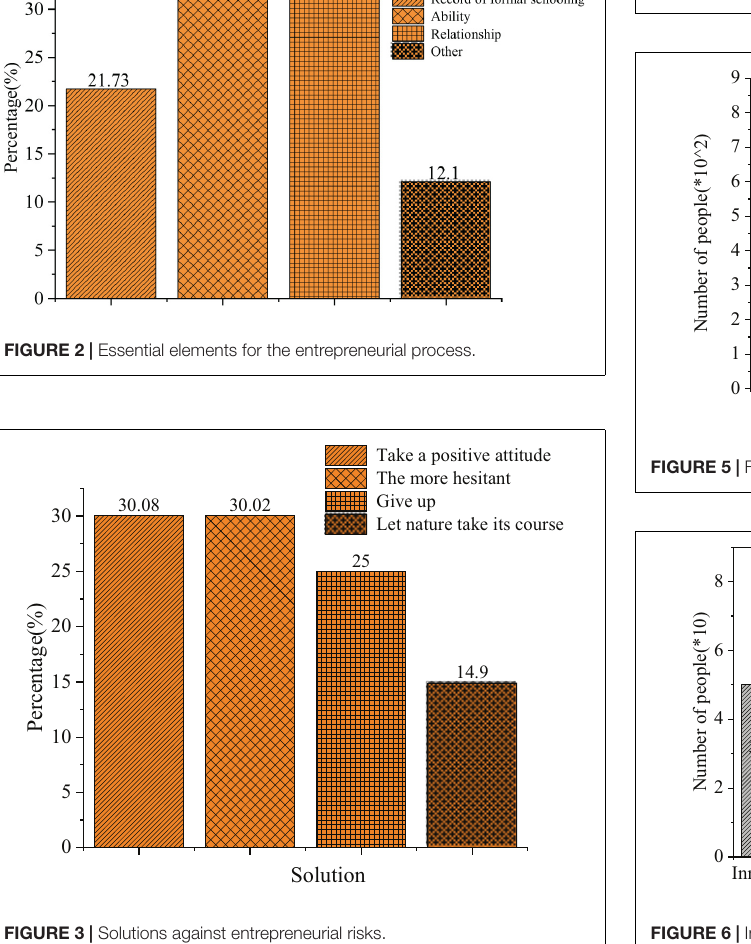
FIGURE 4 | Factors of entrepreneurial failure.